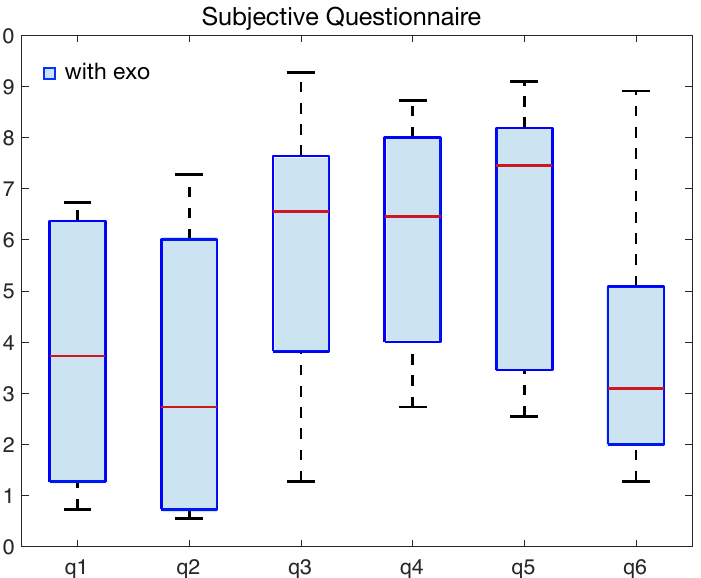
Figure 4. Boxplots of the user’s impression questionnaire regarding the physical and mental load perceived by participants when executing the task in the exo assistance mode. The red lines represent the sample median, the distances between the tops and bottoms are the interquartile ranges. Whiskers show the min and max values. 0 = strongly disagree, 10 = strongly